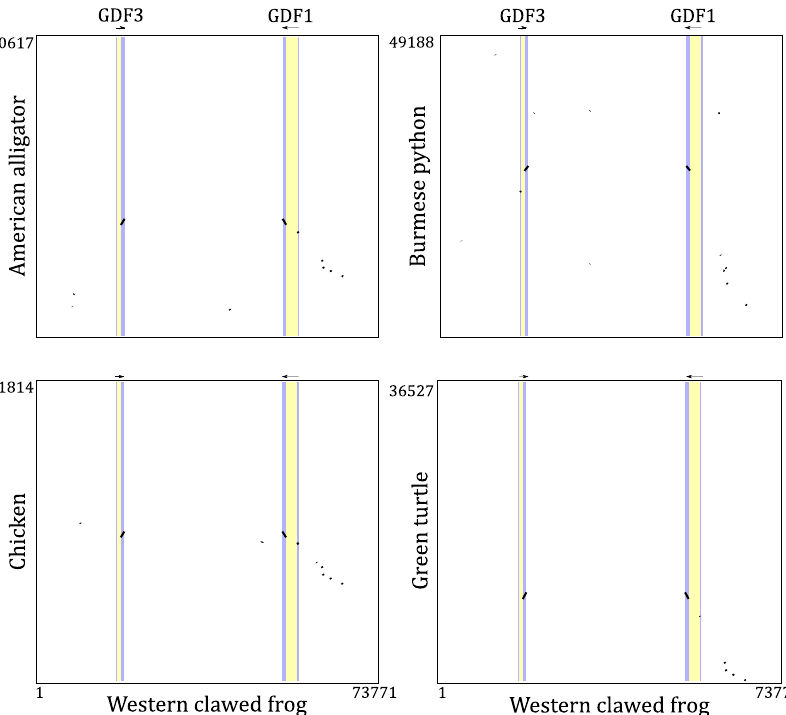
Figure 2. Dot-plots of pairwise sequence similarity between the GDF1 and GDF3 genes of the western clawed frog ( Xenopus tropicalis ) and the corresponding syntenic region in representative species of all main groups of sauropsids, the American alligator ( Alligator mississippiensis ), Burmese python ( Python bivittatus ), chicken ( Gallus gallus ) and green turtle ( Chelonia mydas